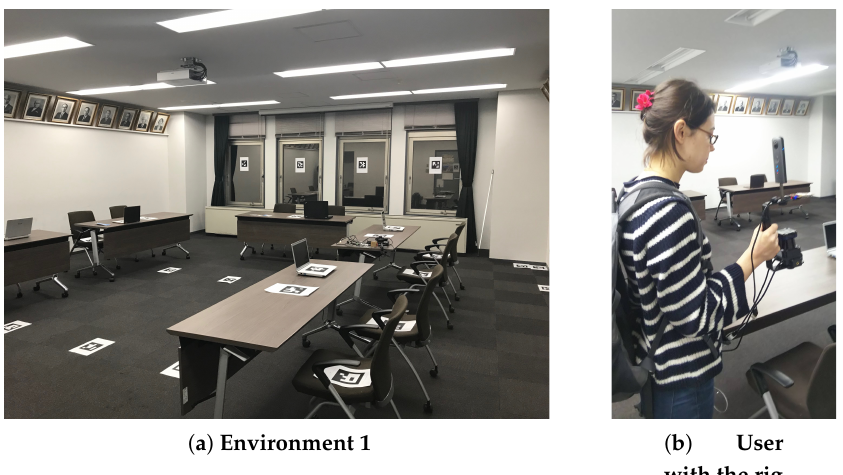
Figure 3. Room-Level Experiment Setting. ( a ) Experiment environment with ArUco markers. ArUco markers are placed on objects to annotate the 2D map. Extra markers are put on the floor to ensure continuity during marker capture for map creation. ( b ) User with experiment equipment, including a rig to hold the sensors required to capture sensor data for the experiment and ground truth for validation. The rig consists of a Ricoh Theta V camera, Sparkfun Razor inertial measurement unit (IMU) for system input and a Hokuyo range finder to construct the ground